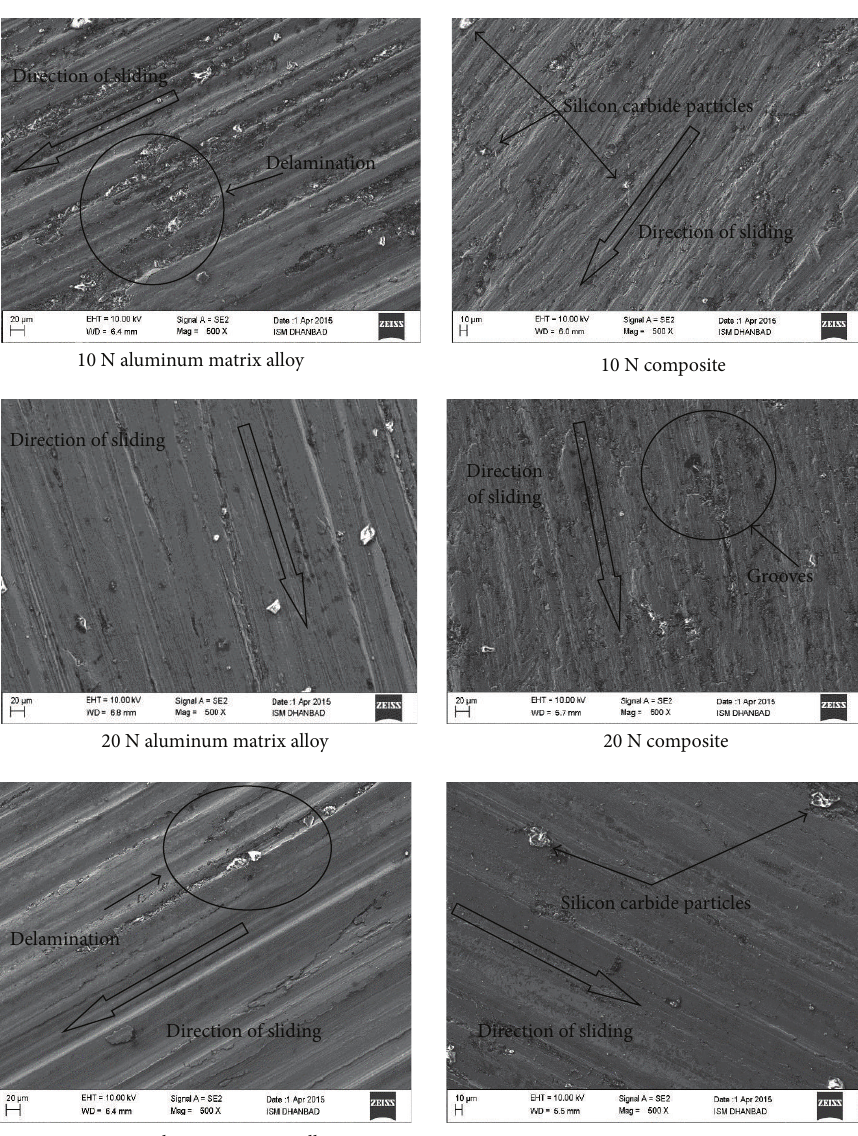
Figure 6: FESEM of worn surfaces at different loads with sliding speeds 3.14m/s under dry